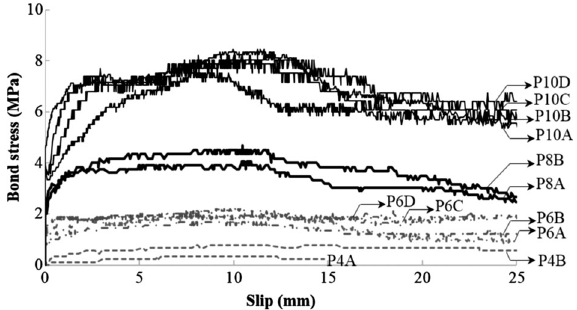
Fig. 5 Experimentally observed bond stress–slip relation- ships measured at different maturity phases of